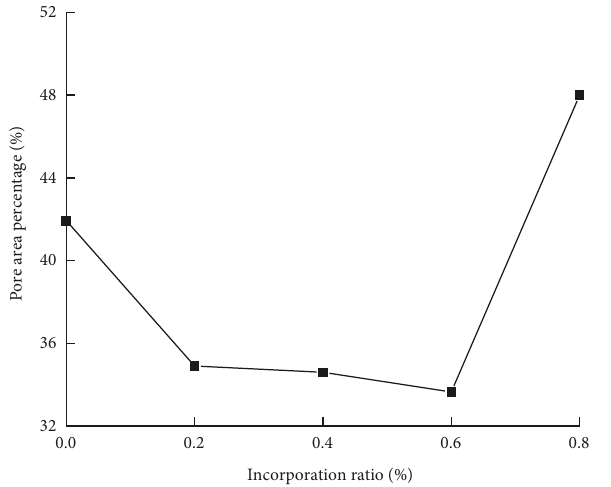
Figure 13: Pore area percentage versus incorporation ratio.